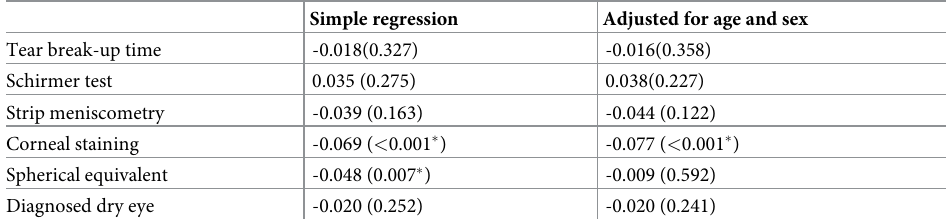
Table 2. Regression analysis of presence of pandemic and examination